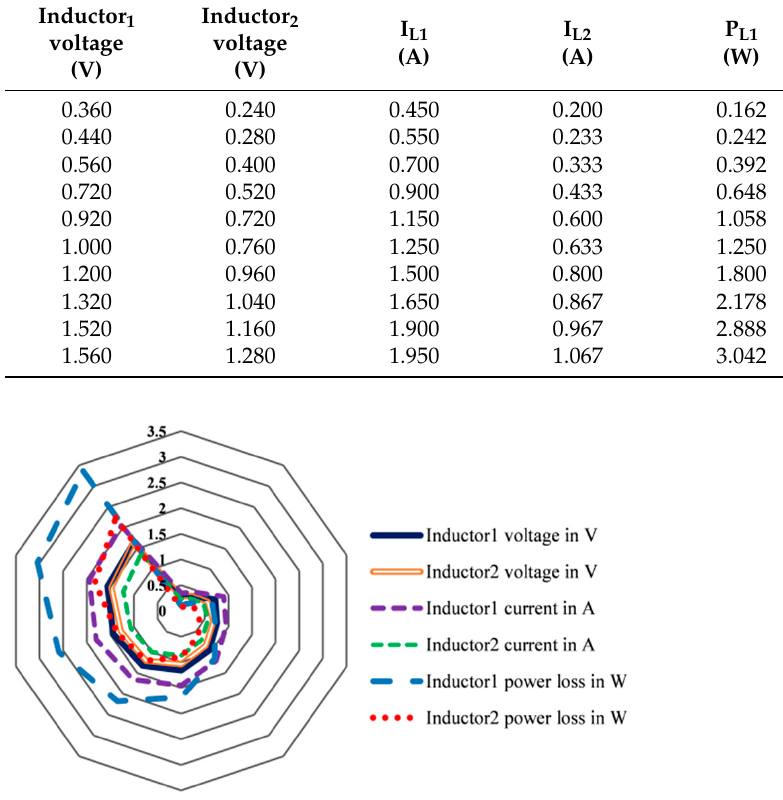
Figure 14. Inductor voltage, current and power loss comparison at f s = 5 kHz and D = 50%. Table 14. Inductor voltage, current and power loss at f s = 10 kHz and D = 50%.